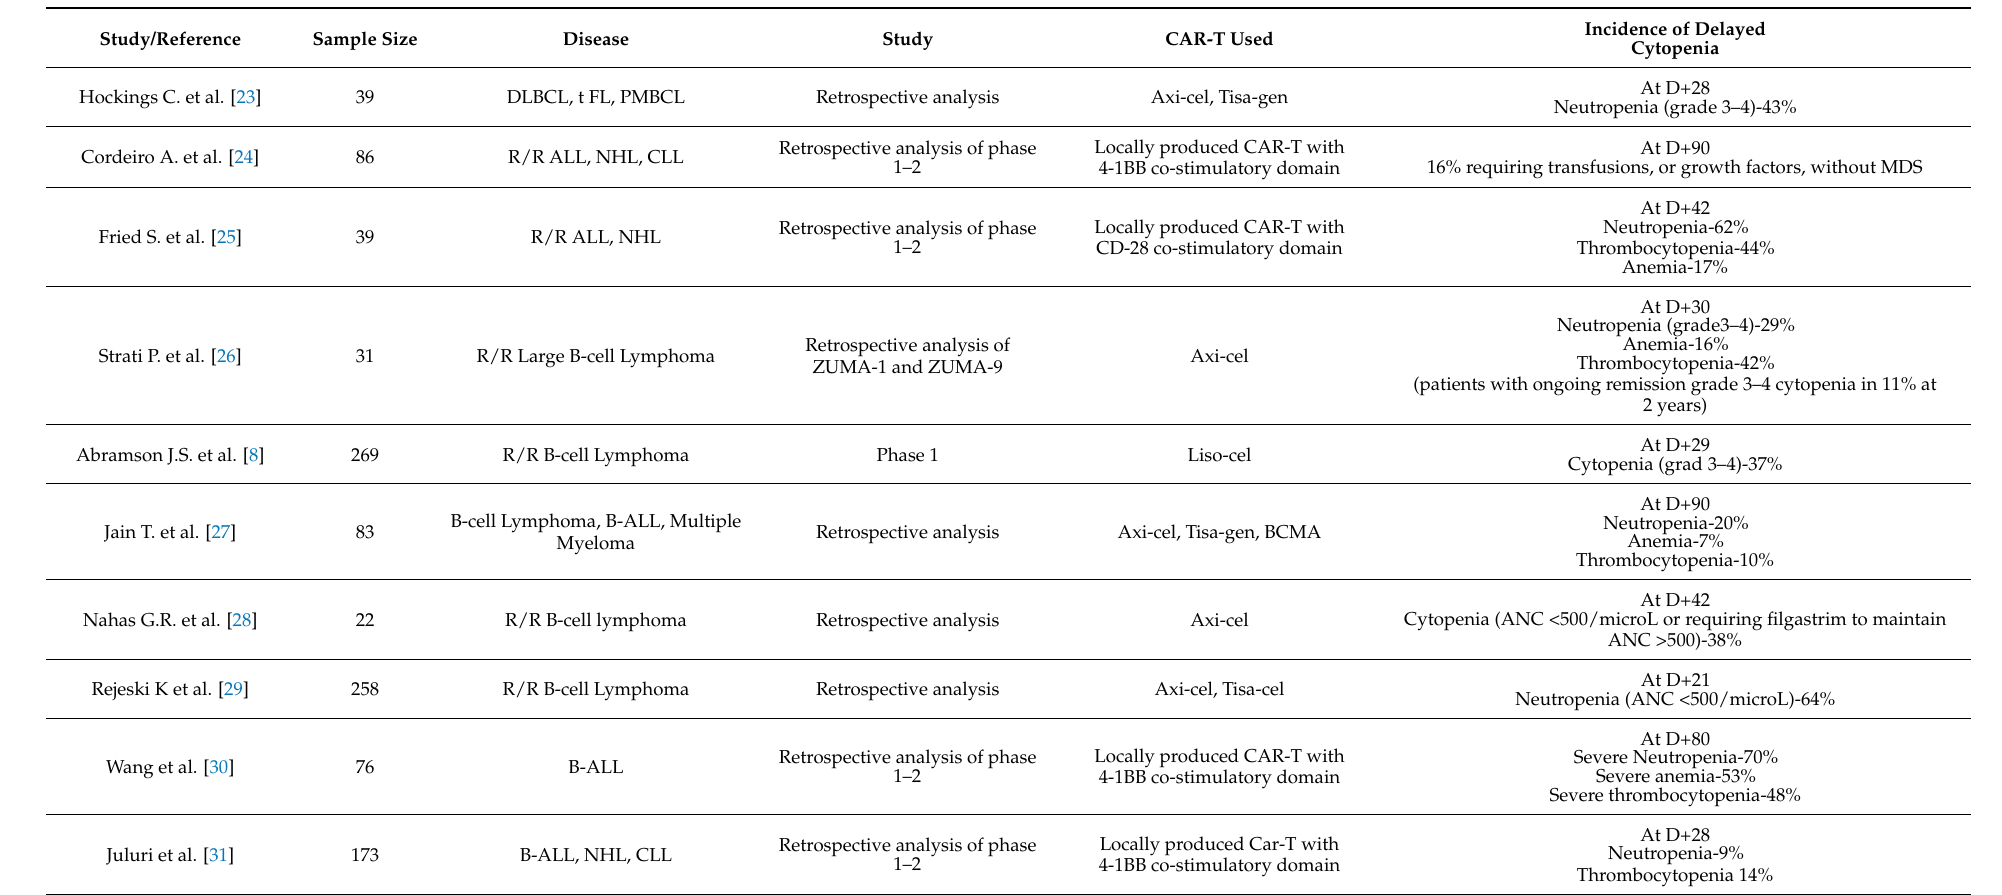
Table 1. Incidence of Cytopenias In a Sampling of CAR-T